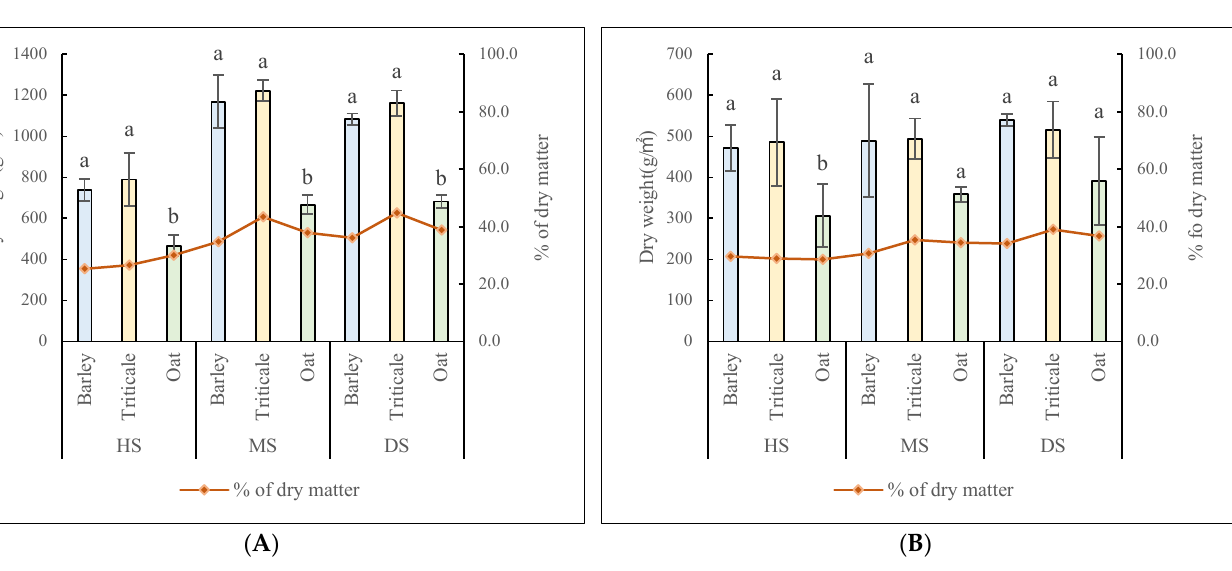
Figure 2. Measurement of changes in dry weight and percentage of dry matter according to the growth period of three winter cereals over two years. ( A ) = 2018–2019, ( B ) = 2019–2020; heading stage: HS, milk stage: MS, dough stage: DS. Values with similar letters are not significantly different.